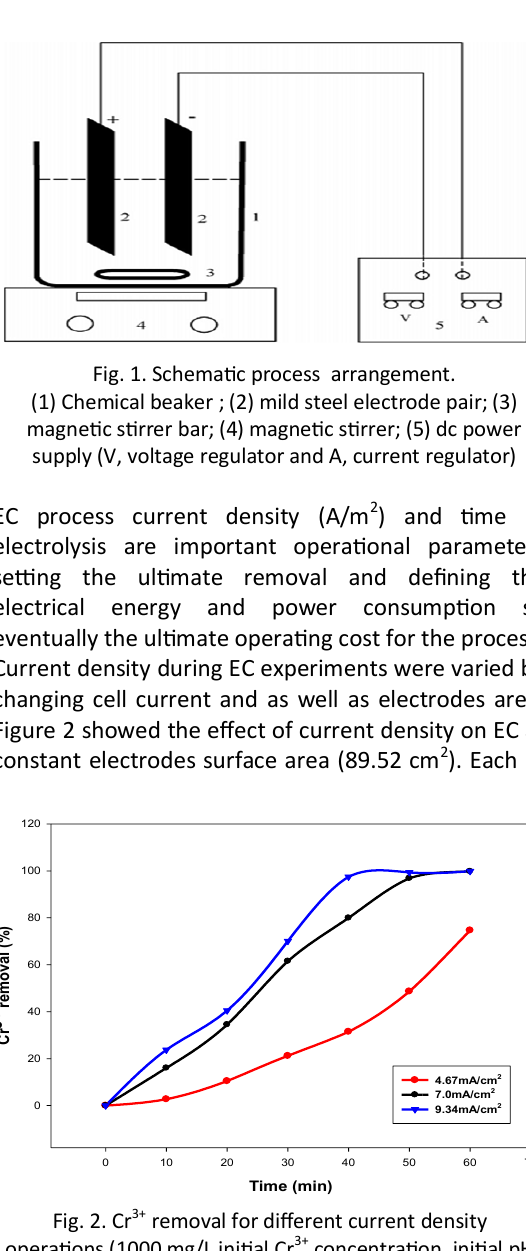
Fig. 2. Cr 3+ removal for different current density operations (1000 mg/L initial Cr 3+ concentration, initial pH 3.4, 85.65 cm 2 electrode area, 1000 mg/l these experiments was conducted with same initial concentration of 918.3 mg/l of Cr. After 60 min of EC, 74.66, 99.82 and 99.89% Cr 3+ from the liquid phase was found to be transferred to sludge phase at current densities of 4.67, 7.0 and 9.34 mA/cm 2 , respectively. Therefore, effective removal of Cr 3+ from the supernatant by electrocoagulation is observed at higher current densities. Higher dissolution of electrode material (Faraday’s law) with high rate of formation of monomeric and/or polymeric iron hydroxides result in significant improvement in Cr 3+ removal mainly due to co-precipitation forming solid solution like species. This effect is solely dominant at the beginning of the experiments as Cr(OH) is significantly soluble at this pH (at the initial stage) and